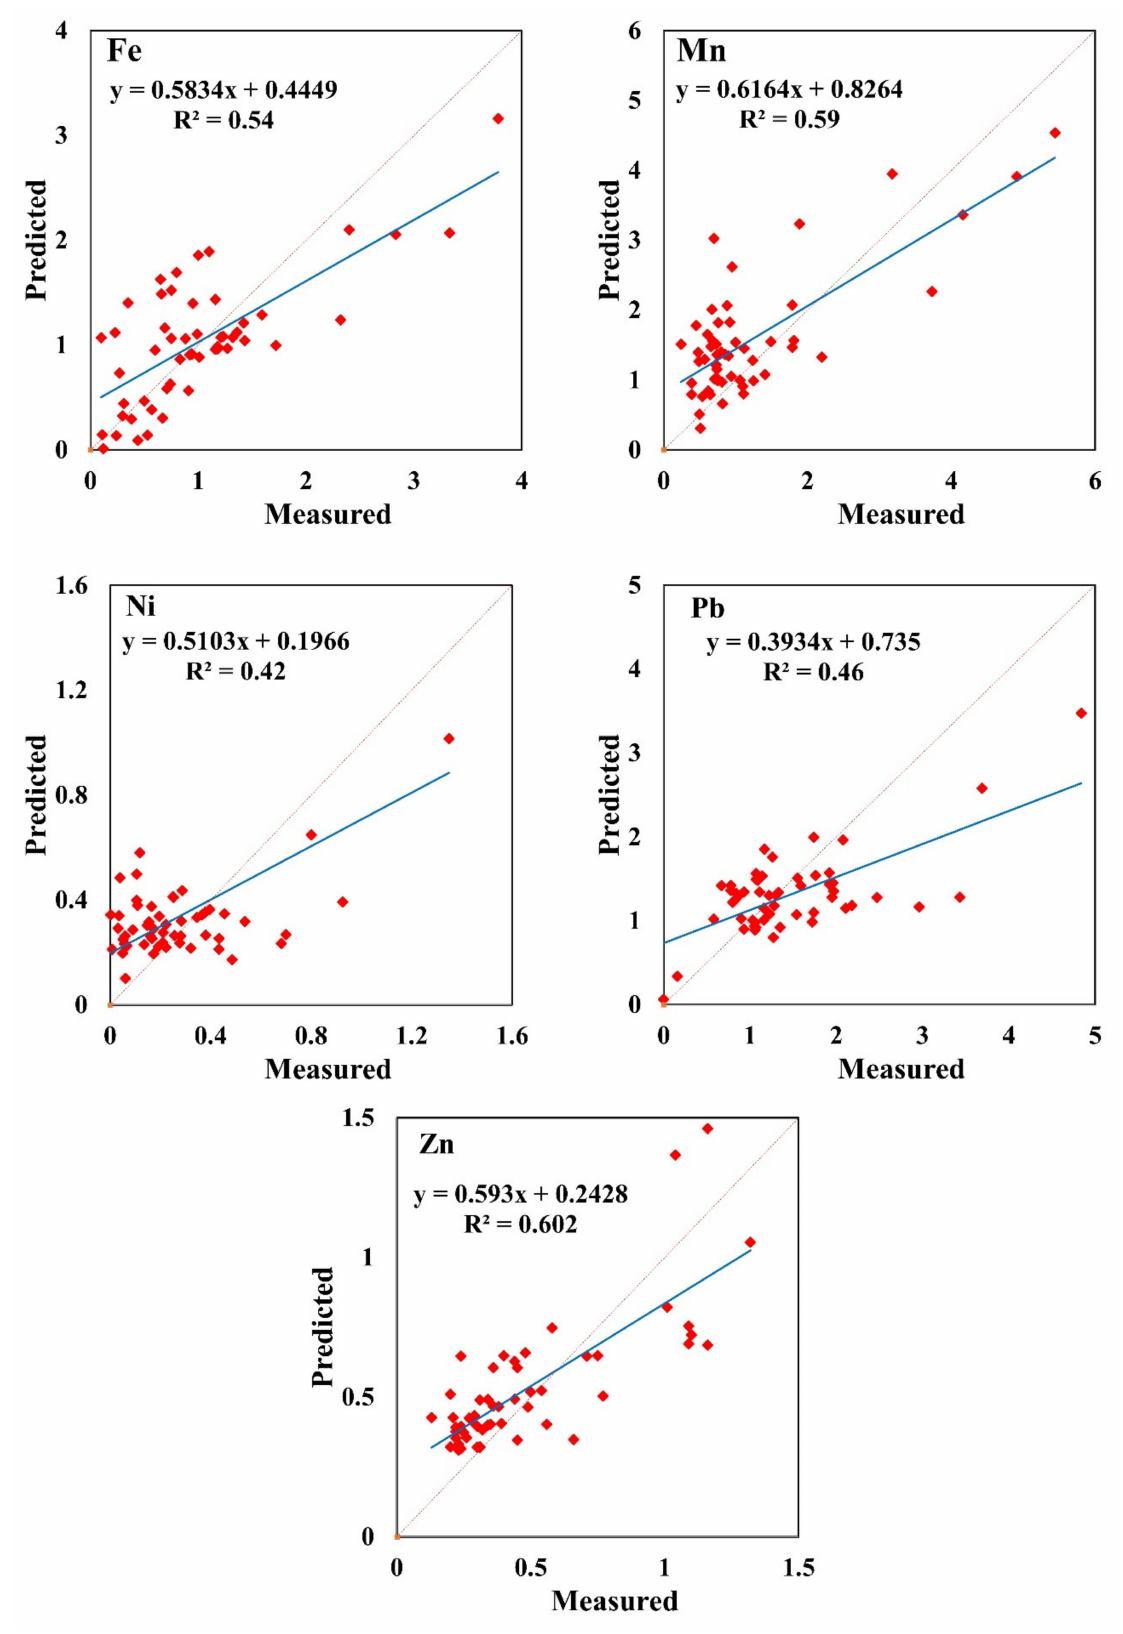
Figure 5. Scatterplots of predicted and measured soil heavy metals (mg/kg − 1 ) using the RF